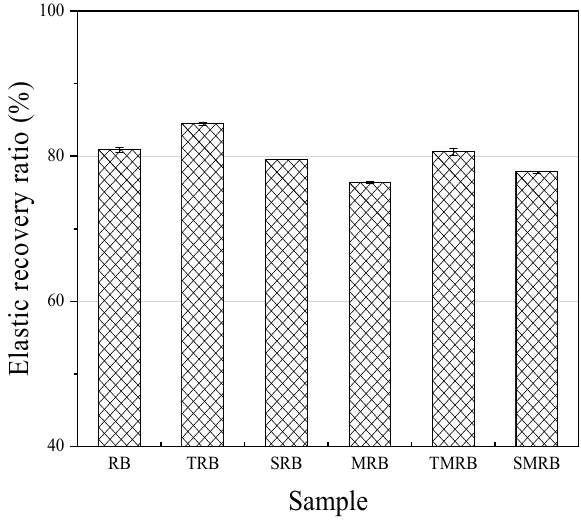
Figure 4. Elastic recovery of rubberized bitumen.